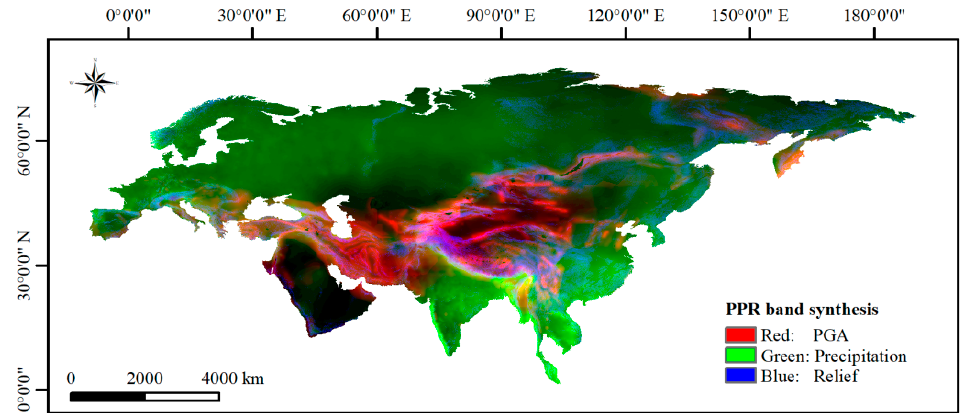
Figure 4. Pseudocolor representation of PPR 3D geo-information space data.